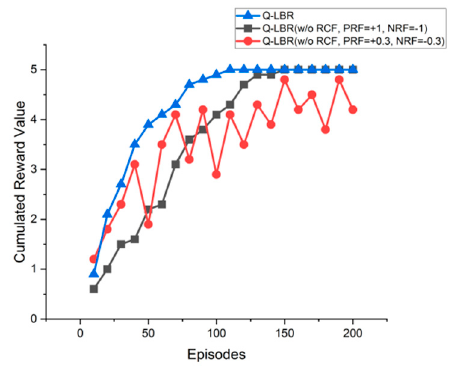
Figure 9. Q-LBR versus Q-LBR without Reward Control Function (RCF) for Cumulated Reward Value.